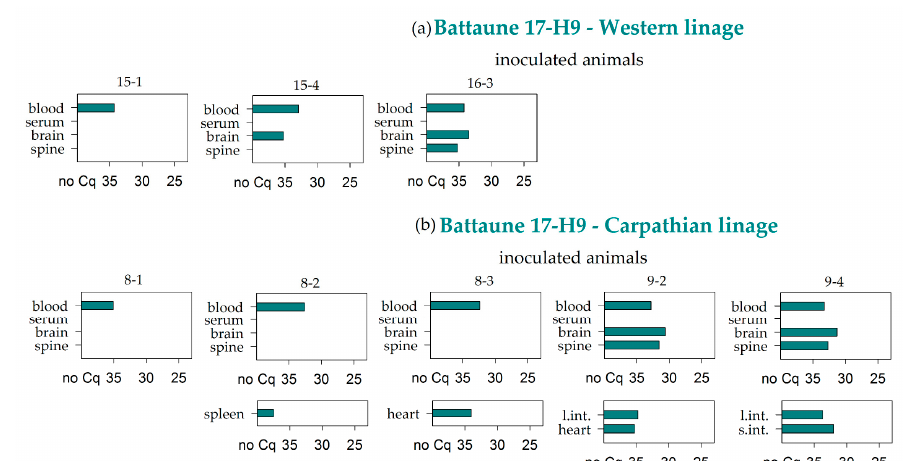
Figure 5. RT-PCR results of blood, serum, brain, and spine samples for the bank voles of the Western ( a ) Figure 5 and Carpathian ( b ) lineages that were inoculated with the Battaune TBEV-Eu strain. Further additional positive samples are listed per animal. Measures are given in quantification cycle values (Cq). S.int. and l. int.: small and large intestine.